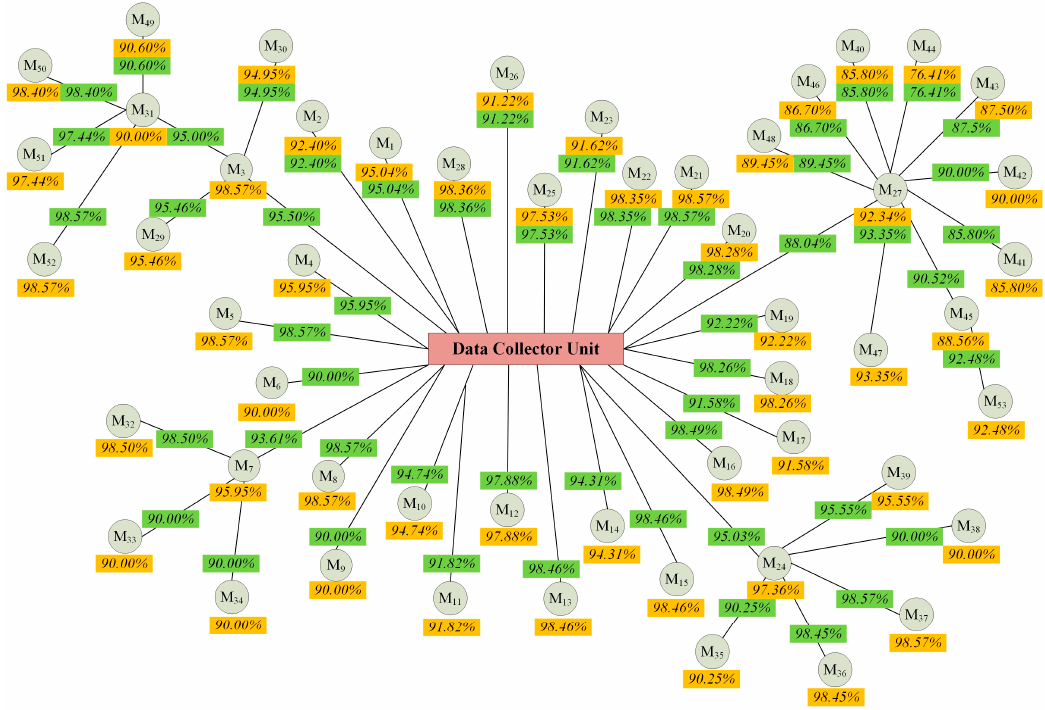
Figure 17. Calculated CPIs of Day 1 for Actual Small-Scale PLC-based AMI.